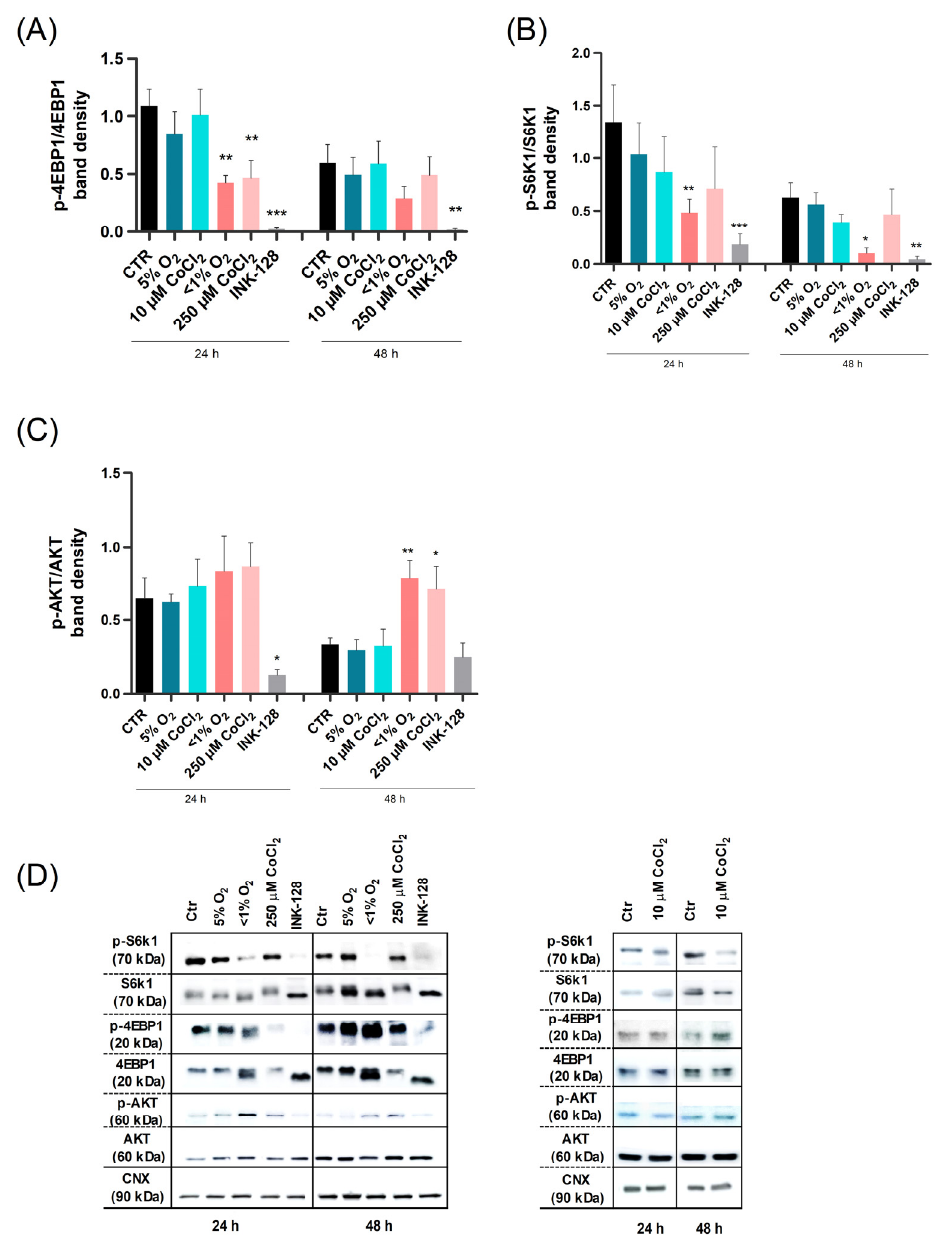
Figure 3. Effect of hypoxia on UC-MSCs is linked to the mTOR pathway. UC-MSCs underwent control (21% O 2 and INK-128) and experimental conditions (5% O 2 , <1% O 2 , 10 µ M CoCl 2 , and 250 µ MCoCl 2 ) for 24 and 48 h, after which protein analysis was carried out via Western blot. ( A – C ) Protein band quantification of two mTORC1 targets (p-4EBP1/4EBP1 and p-S6K1/S6K1) and a mTORC2 target (p-Akt/Akt), normalized to the loading control calnexin (CNX). The ratio between phosphorylated and total forms could be used to infer protein function. ( D ) Representative immunoblot of the total and of the respective phosphorylated form of the 4EBP1, S6K1, and Akt proteins. Results are represented as means with SEM of a minimum of 3 independent experiments. Statistical significance considered when * p < 0.05%, ** p < 0.01, and *** p <